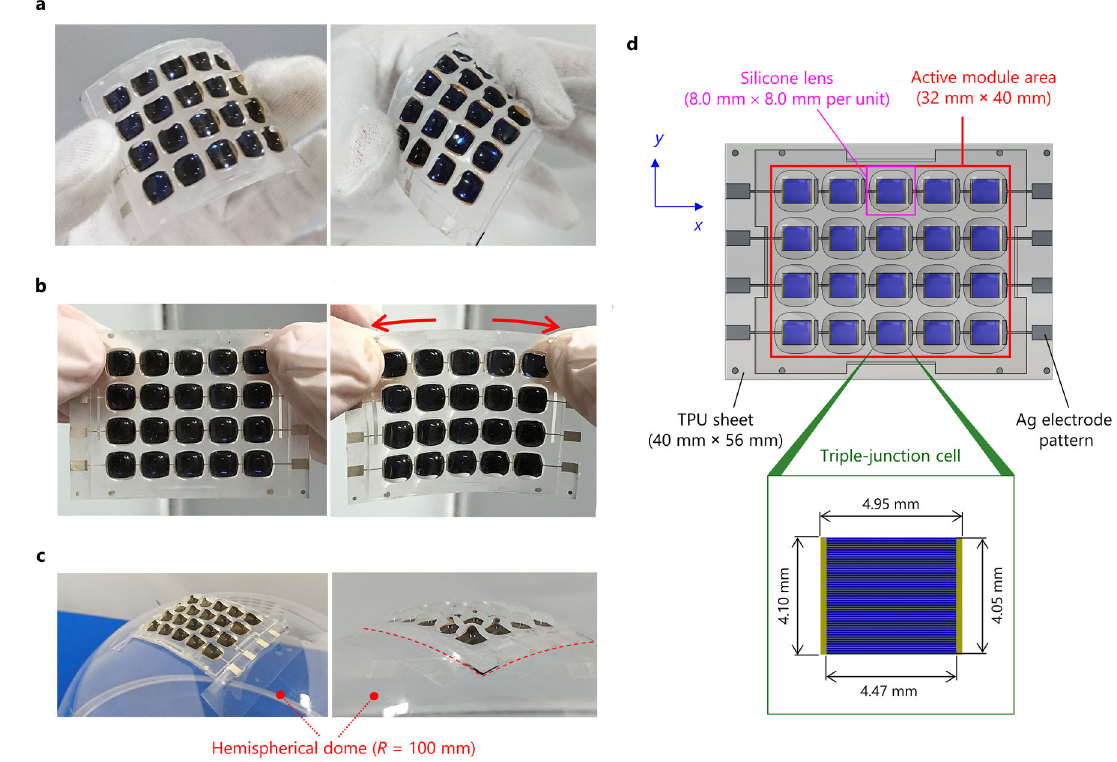
Fig. 1 Stretchable micro-scale CPV module. a – c Photographs of prototype module. a Flexibility, ( b ) Stretchability (left: relaxed state; right: stretch state), and ( c ) Module covering a hemispherical dome with curvature radius, R = 100 mm. d Schematic representation of the top side view of prototype